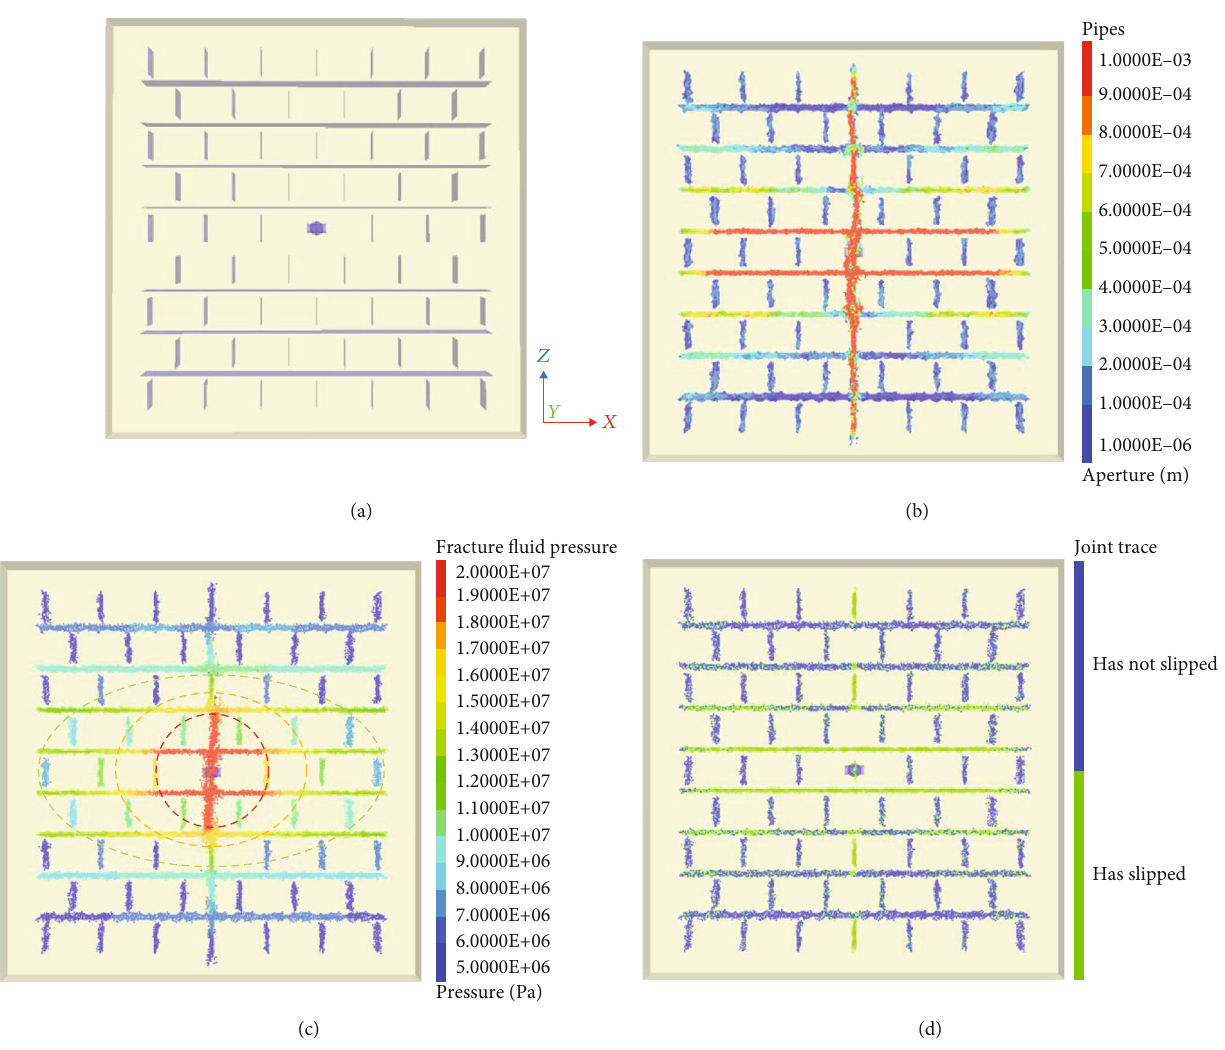
Figure 22: Type B NFN: (a) model setup, (b) fracture aperture, (c) fracture fl uid pressure, and (d) shear slip on the